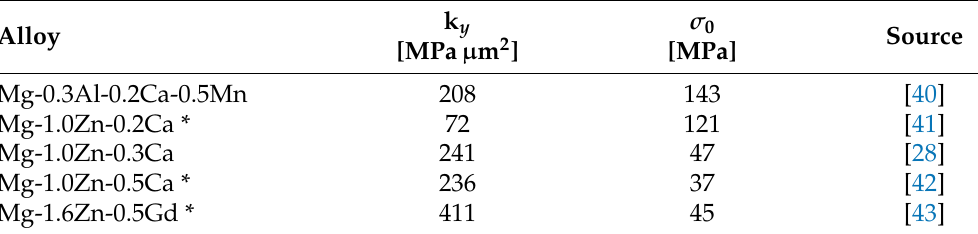
Table A3. Overview of the alloys and corresponding constants, Hall–Petch slope (k y ) and frictional stress ( σ 0 ) used in Figure 3. The Hall–Petch relationship YS = k y ∗ d − 1/2 + σ 0 , where d represents the grain diameter, was used for the calculation of the YS depicted in Figure 3b. The values of the alloys marked with an asterisk(*) have been calculated from the microstructure given in the corresponding source